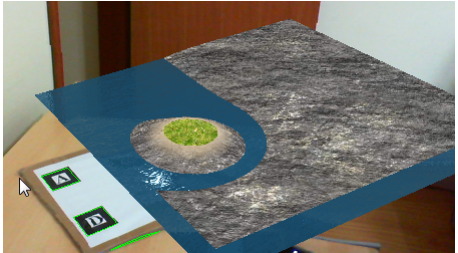
Fig. 15. Attraction force example.